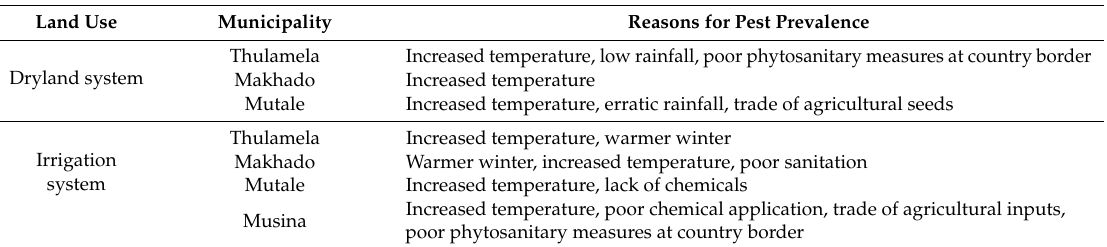
Table 7. Factors influencing insect pest prevalence mentioned in FGDs by smallholder farmers.